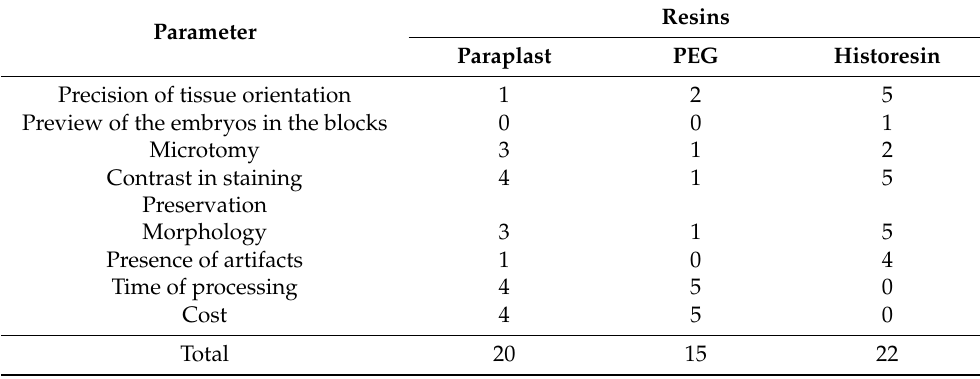
Table 9. Comparison of scores assigned to the parameters analyzed in each resin. Resins Parameter Paraplast PEG Historesin Precision of tissue orientation 1 2 5 Preview of the embryos in the blocks 0 0 1 Microtomy 3 1 2 Contrast in staining 4 1 5 Preservation Morphology Presence of artifacts Time of